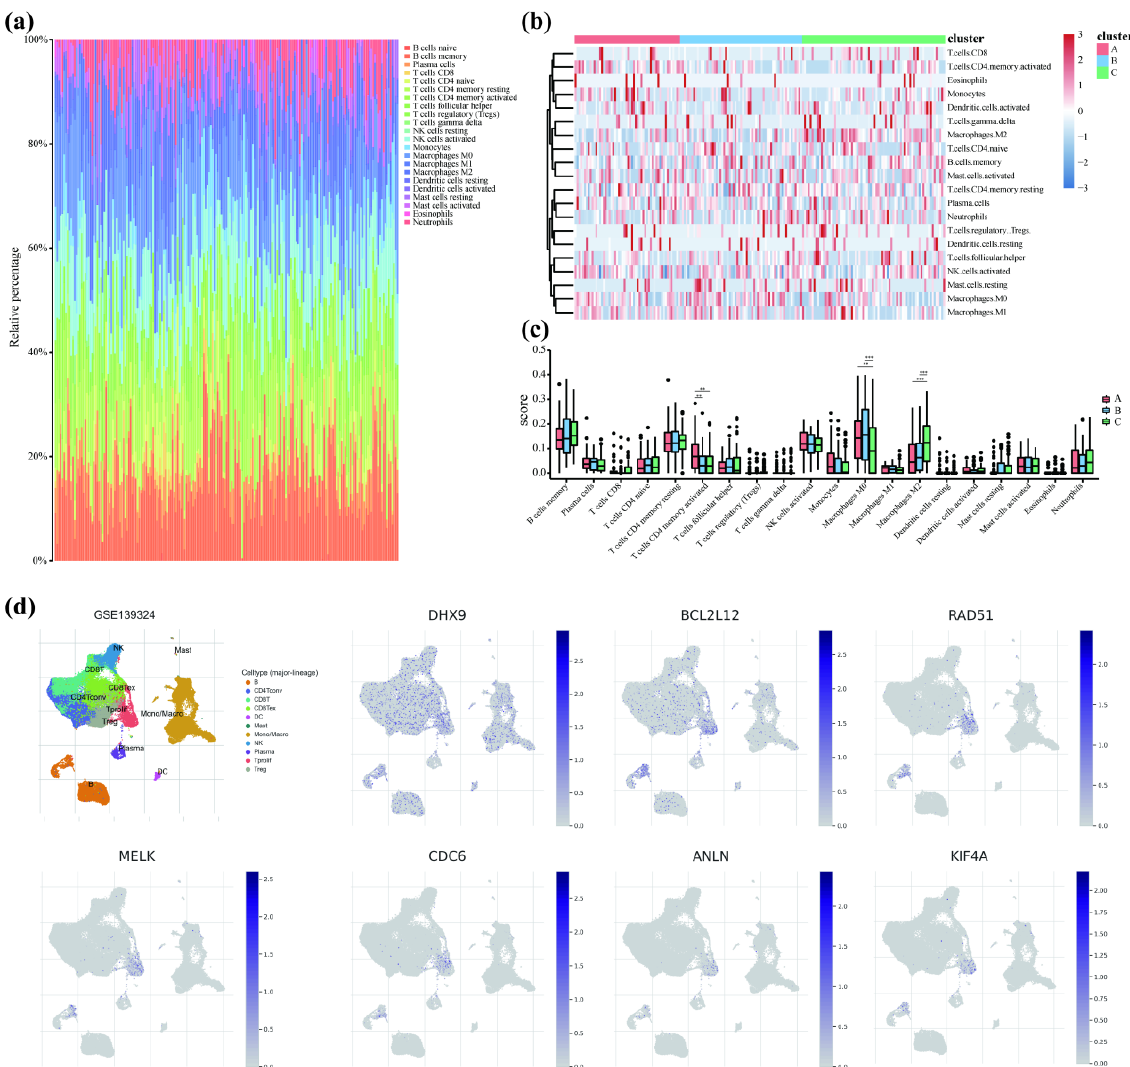
Figure 6. Model genes affecting immune cell infiltration. ( a ) Bar plot of immune cell correlations was analyzed using CIBERSORTx. ( b ) Heatmap constructed based on subtype groups shows the infiltration of different immune cells in three subtypes. Red indicates upregulation, and blue indicates downregulation. (c) Group comparison plot of various immune cells grouped according to subtypes (** p < 0.01; *** p < 0.001). ( d ) The expression of model genes in different immune cells using single-cell from GSE139324. B: B cells, CD4Tconv: conventional CD4 T cells, CD8T: CD8 T cells, CD8Tex: exhausted CD8 T cells, DC: dendritic cells, Mast: mast cells, Mono/Macro: monocytes or macrophages, NK: natural killer cells, Plasma: plasma cells, Tprolif: proliferating T cells,